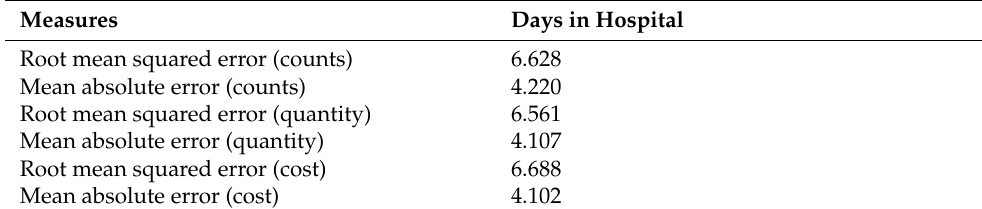
Table 5. Updated length of stay scenario: regression forecast results for length of